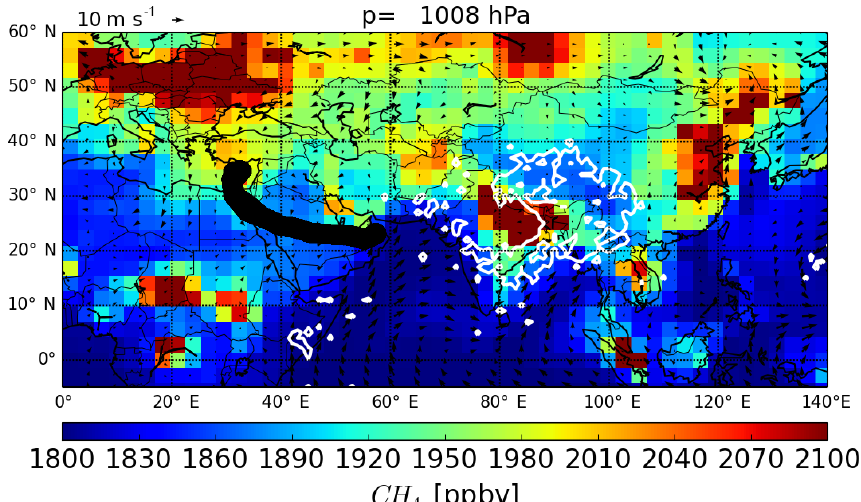
Figure 13. EMAC calculated CH 4 ; daily mean at the surface (1008hPa, 3 August 2015) as an indicator for surface emissions (10 days prior to measurements), and the track of flight 19 (black). Additionally, the footprint of the last boundary layer contact is shown as white contour line from Fig. 11.